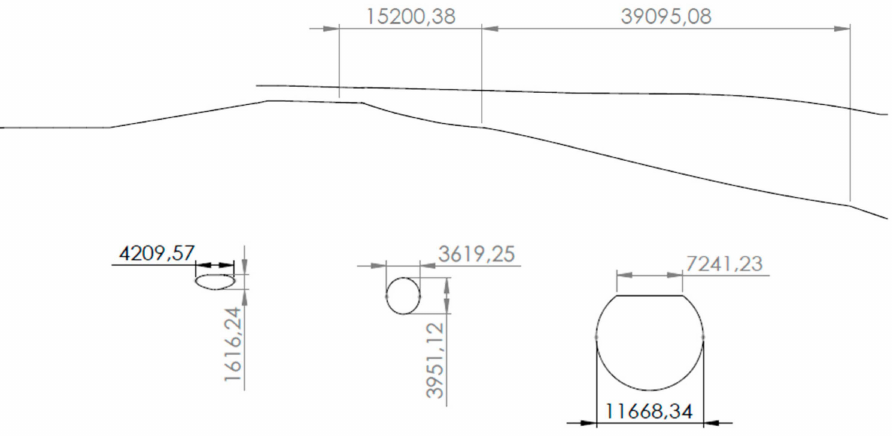
Figure 8. Extension of protected powerplant surfaces (mm).